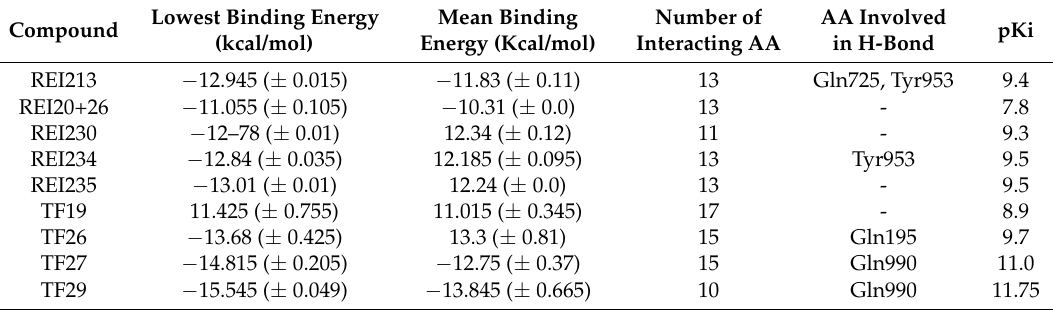
Table 3. Molecular docking of artemisinin-, egonol-, and thymoquinone-based hybrids on homology-modelled human P-glycoprotein in the transmembrane